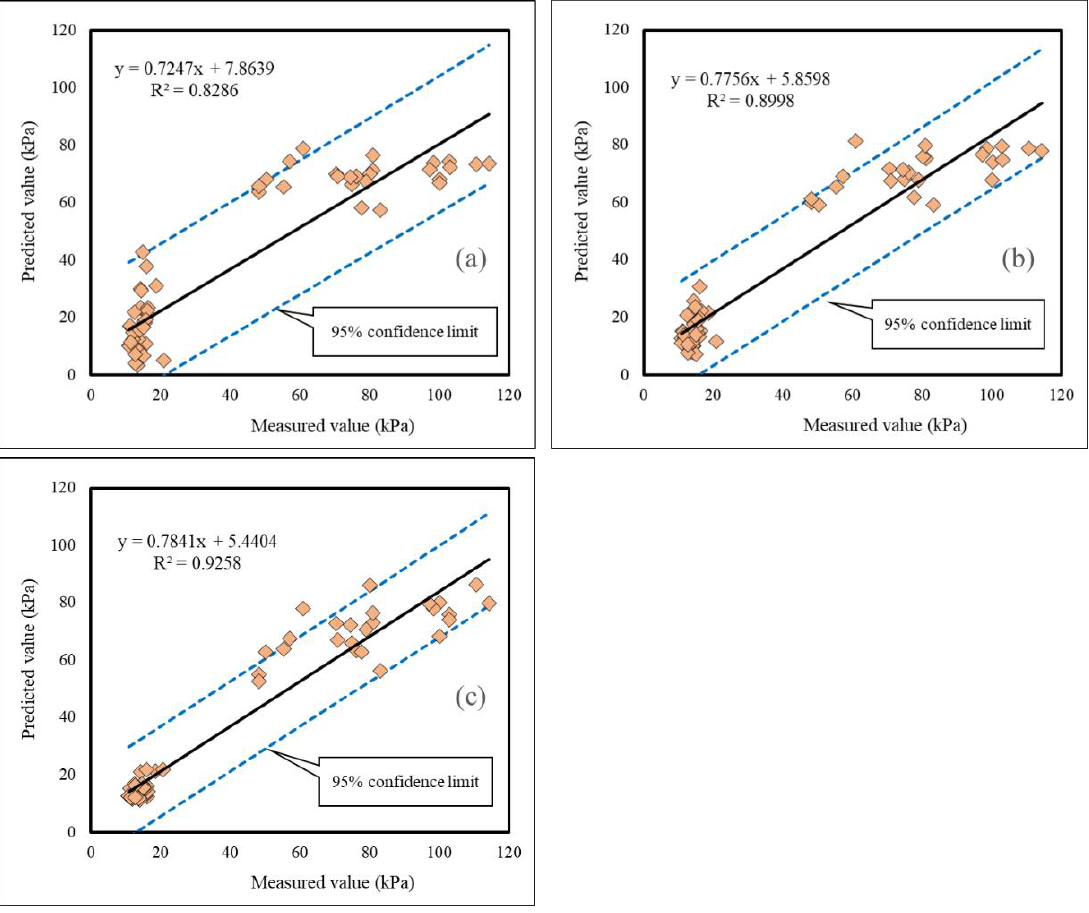
Figure 8. The correlation between the measured and predicted shear strengths in the testing phases; ( a ) R 2 = 0.8286, ( b ) R 2 = 0.8998, ( c ) R 2 =